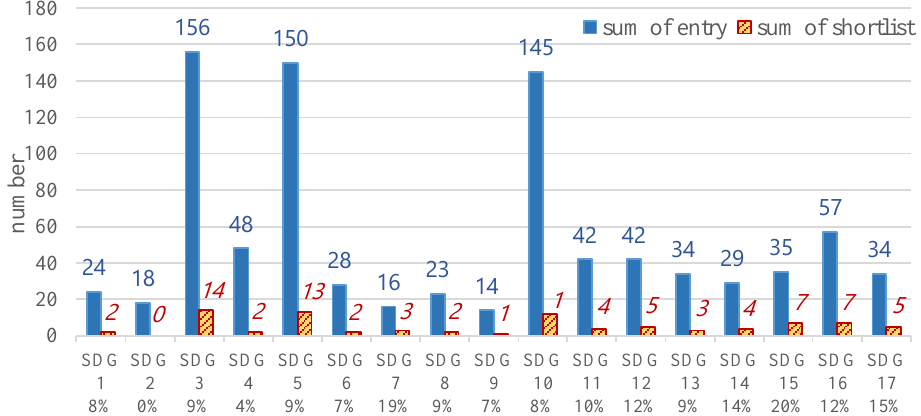
Figure 3. The proportion of each SDG’s entries (blue bars and numbers) to shortlists (orange line and numbers) in 2018 SDG Lions.